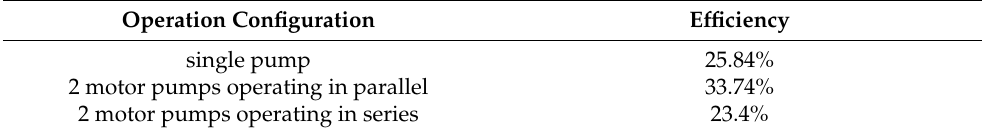
Table 9. Comparison of energy efficiency for different topologies of controlled water pumping system